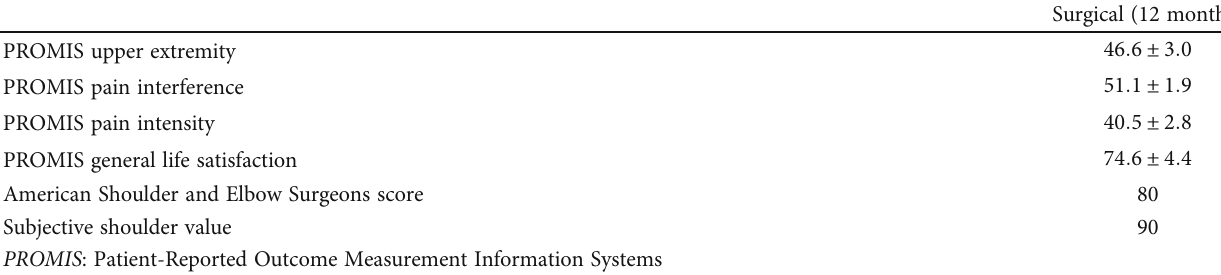
Table 1: Patient-reported outcomes.